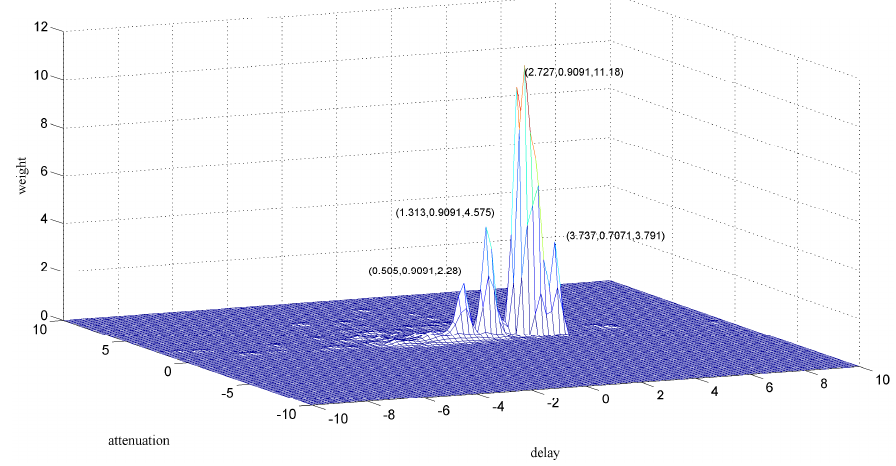
Figure 12. Clustering result of section a2 into four particles.